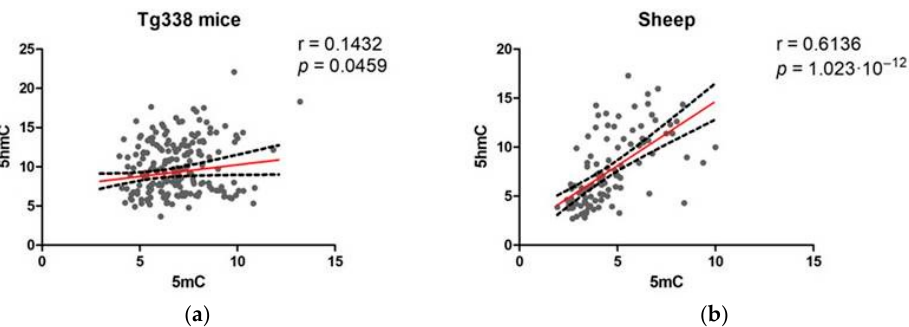
Figure 12. Pearson’s correlation between 5mC and 5hmC in ( a ) Tg338 mice and ( b ) sheep.